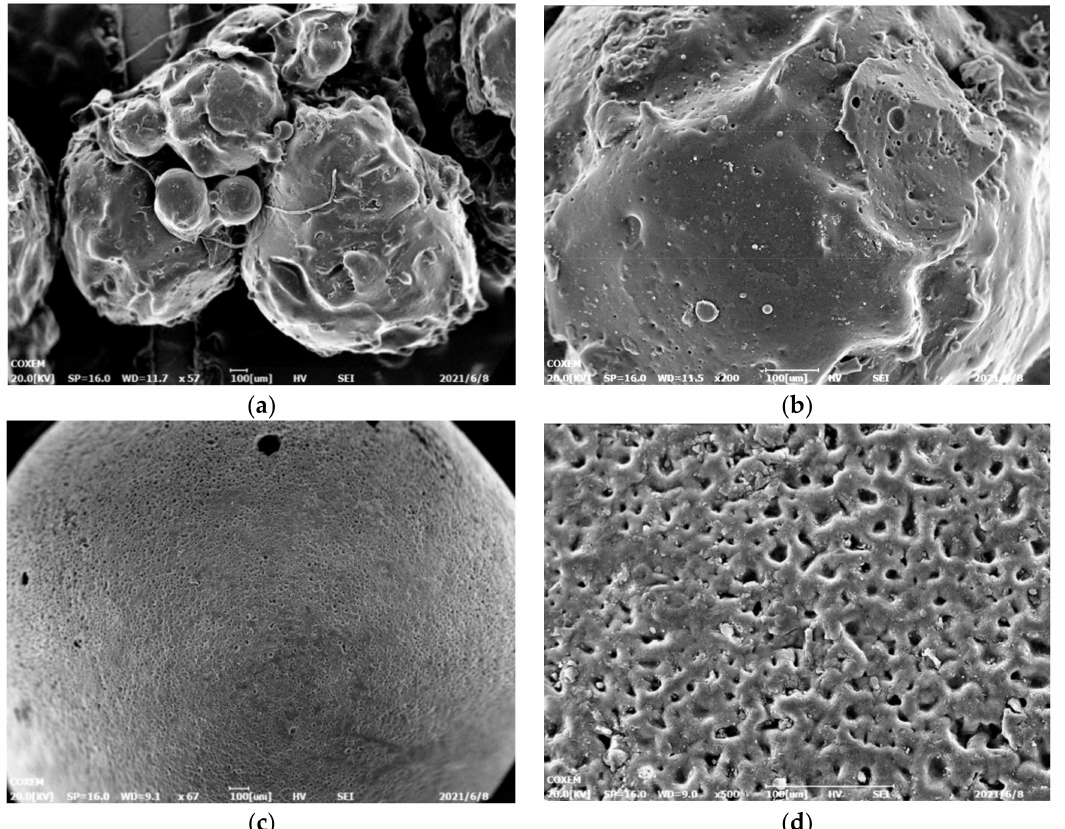
Figure 3. Proppant particles and surface morphology obtained from sodium dodecyl benzene sul- fonate and solid particle emulsifier. (( a , b ) are the proppant particles and surface morphology obtained from sodium dodecylbenzene sulfonate; ( c , d ) are the proppant particles and surface morphology obtained from solid particle emulsifier.)